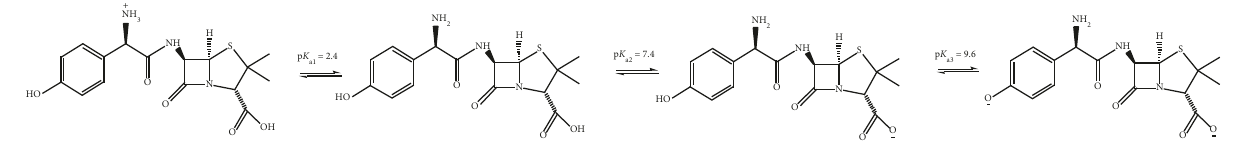
Figure 5: Changes of AMO speciation by solution